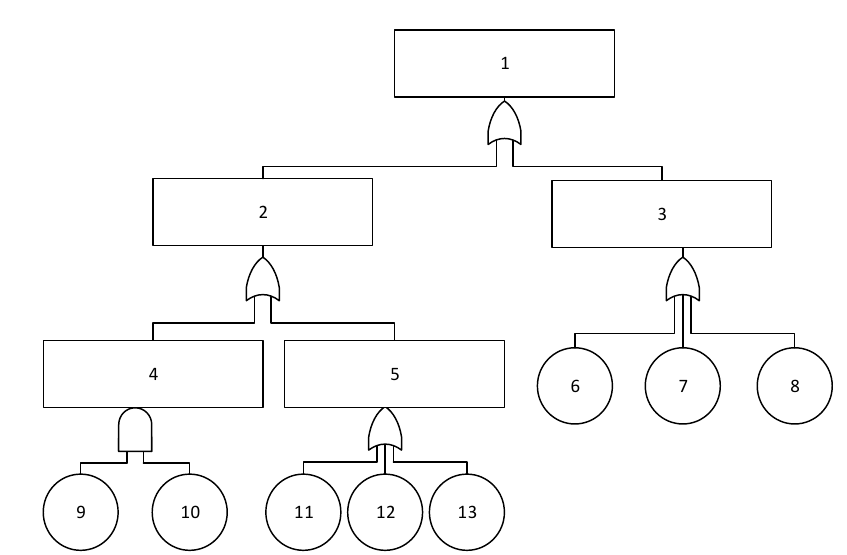
Figure A5. Fault tree of secondary system isolation failure. Note: 1 = secondary system isolation Figure. 2 = valve fails to closed automatically. 3 = valve fails to closed manually. 4 = isolation valve fail. 5 = detector system fail. 6 = signal fail (B8). 7 = display fail (B9). 8 = operator fails to operate the valve (B7). 9 = valve PA-01-AA-14 fail/stuck (B14). 10 = valve PA-01-AA-16 fail/ stuck (B15). 11 = detector fail (B4). 12 = transmitter fail (B5). 13 = buffer fail (B6).